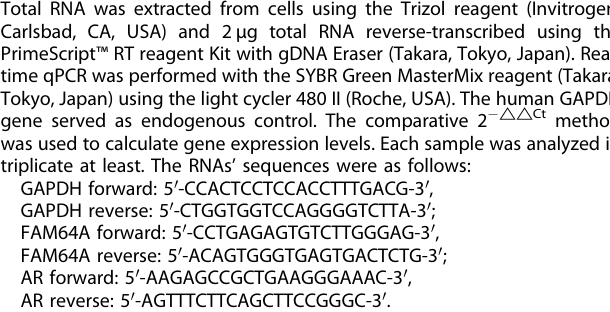
Fig. 5 The expression level of FAM64A could regulate the relevant genes of immunity and interferon by the JAK – STAT-signaling pathway in PCa. a Red dots represent genes with fold change ≥ 2 and P < 0.05, green dots represent genes with fold change ≤ − 2 and P < 0.05, and the other dots represent the rest of genes with no statistically signi fi cant change in NC and siRNA-FAM64A cells by Volcano map. FC fold change. b Venn diagram of up-regulated genes and down-regulated genes. c The red color represents up-regulated genes and the green color represents down-regulated genes in Heat maps. d Construction of protein – protein interaction (PPI) network of differential expressed genes (DEGs), Red circles are upregulated genes in the PPI network, while green ones are downregulated. e The q-PCR experiment veri fi es that the highest log2FoldChange value of 18 up-regulated genes and 13 down-regulated genes which had been found by transcriptome sequencing to siRNA-NC and siRNA-FAM64A PCa cell lines. f , g The biological functions of the integrated DEGs were explored by GO and KEGG enrichment analysis. h The upregulated genes and downregulated genes were subjected to the DAVID for functional pathway analysis by GO enrichment. i By the TCGA database, the linear relationship of the seq-HTSeq-FPKM-UQ value of FAM64A in prostate cancer patients was analyzed. It was found that the expression level of SNHG18, IFIT3, OAS1, PMSB9, OAS2, UBE2L6, IGFBP3, ZNF48 was linearly related to the expression level of FAM64A, consistent with sequencing results. j Western blot results of key proteins expression for IFN and JAK – STAT- signaling pathway upon the knockdown of